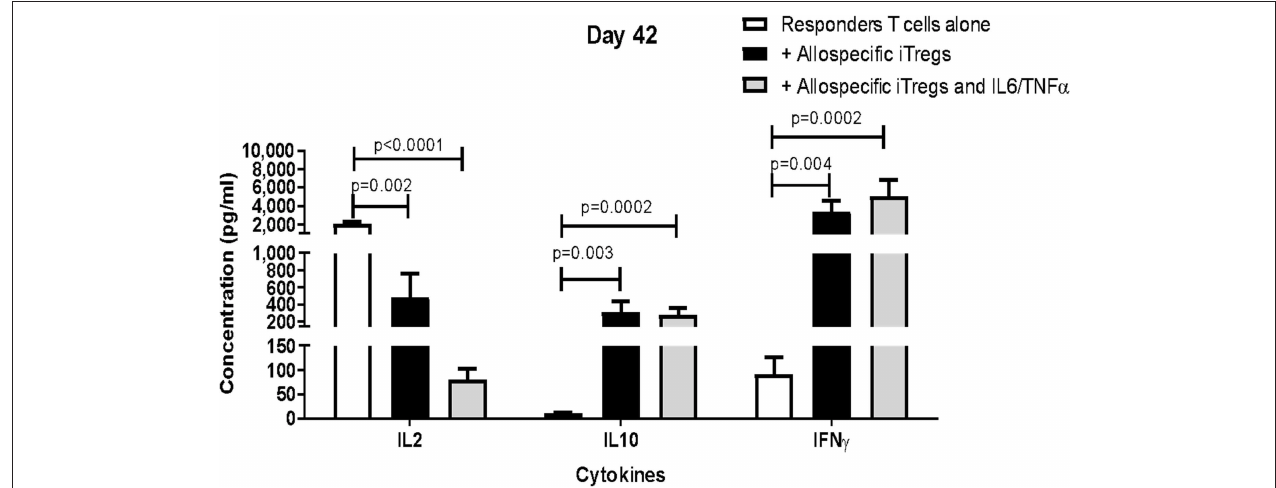
FIGURE 7 | Allospecific expanded iTregs induce production of IL-10 and IFN- γ and downregulate IL-2 to suppress the proliferation of responder T cells. The concentrations of cytokines were measured in the supernatants of the suppression assays. The graphs show the production of cytokines from responder T cells alone (white bar), co-cultures of responder T cells with allospecific iTregs expanded for 6 weeks (black bar), and co-cultures with iTregs expanded for the last 2 weeks with IL-6 and TNF- α (gray bar, lower panel). The measurement of cytokines in the co-cultures indicates a reduction in the production of IL-2 and an increase in